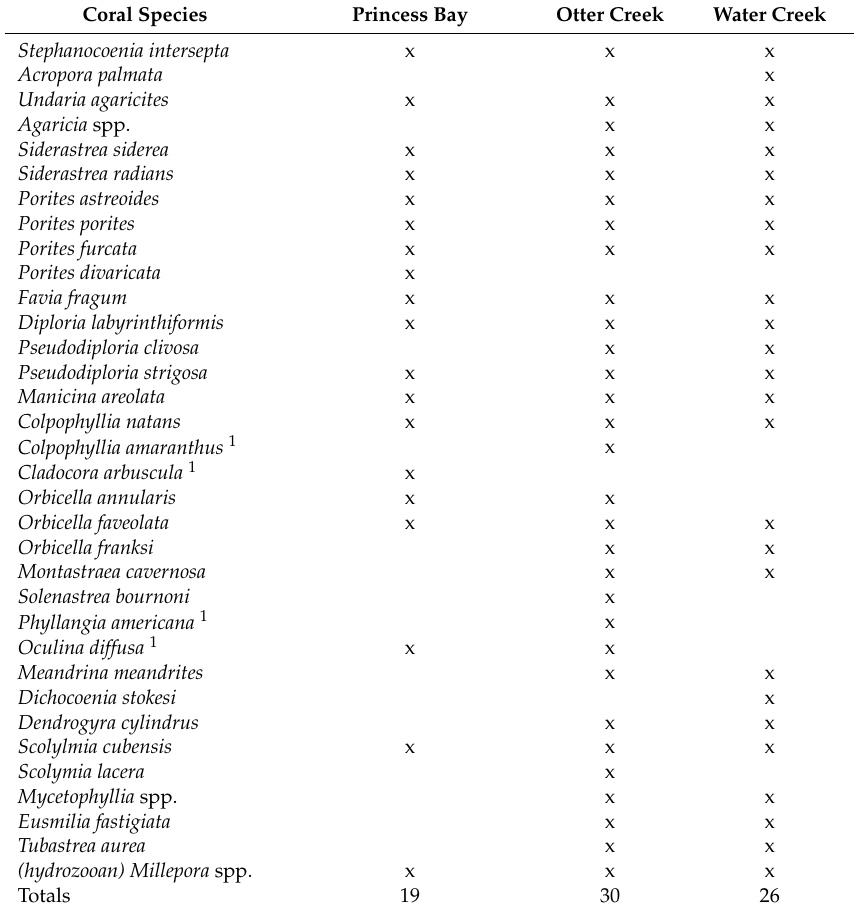
Table 1. Stony corals in Princess Bay, Otter Creek, and Water